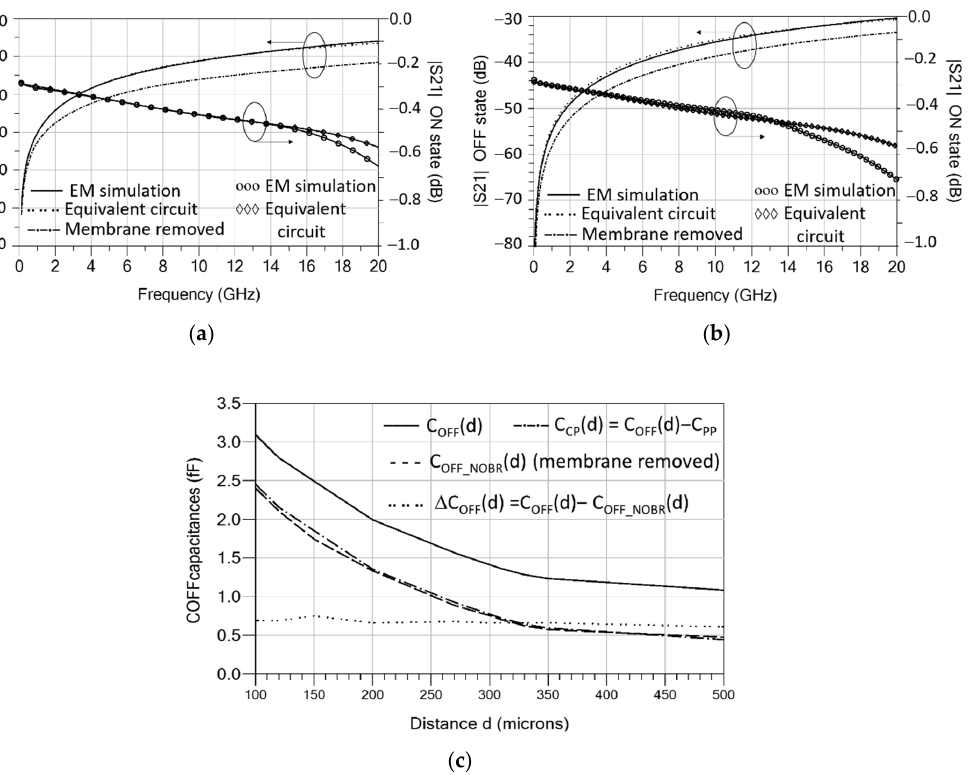
Figure 8. EM ‐ simulated S 21 parameter up to 20 GHz compared to the simulation of the equivalent circuits of Figure 7. ( a ) In ‐ line configuration and ( b ) 90° ‐ rotated configuration. ( c ) OFF ‐ state capacitance fitted to EM simulations for different situations.